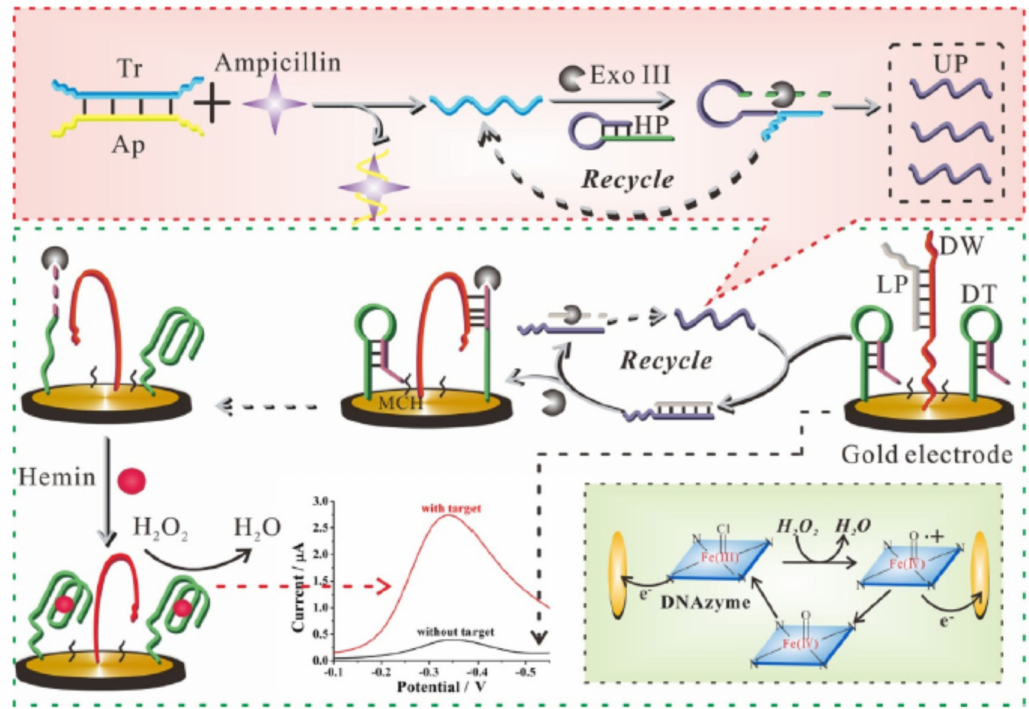
Figure 21. Schematic illustration of a label-free electrochemical aptasensor for the detection of ampicillin based on target- triggered enzymatic cyclic amplification. Reprinted from reference [35] with permission from